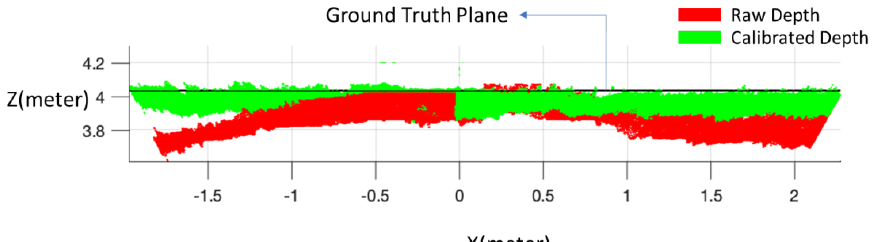
Figure 7. Comparison of real data from the Structural Sensor and simulation data based on the distortion error model .